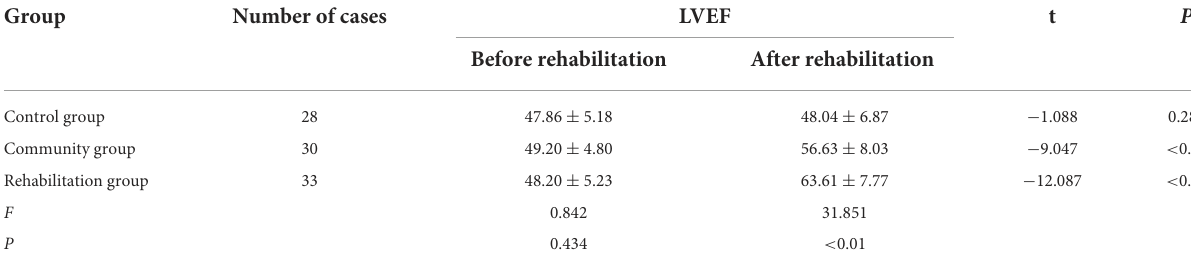
TABLE 2 Comparison among three groups of patients in terms of LVEF before and after rehabilitation ( ¯ x ± s). Group Number of cases LVEF t P Before